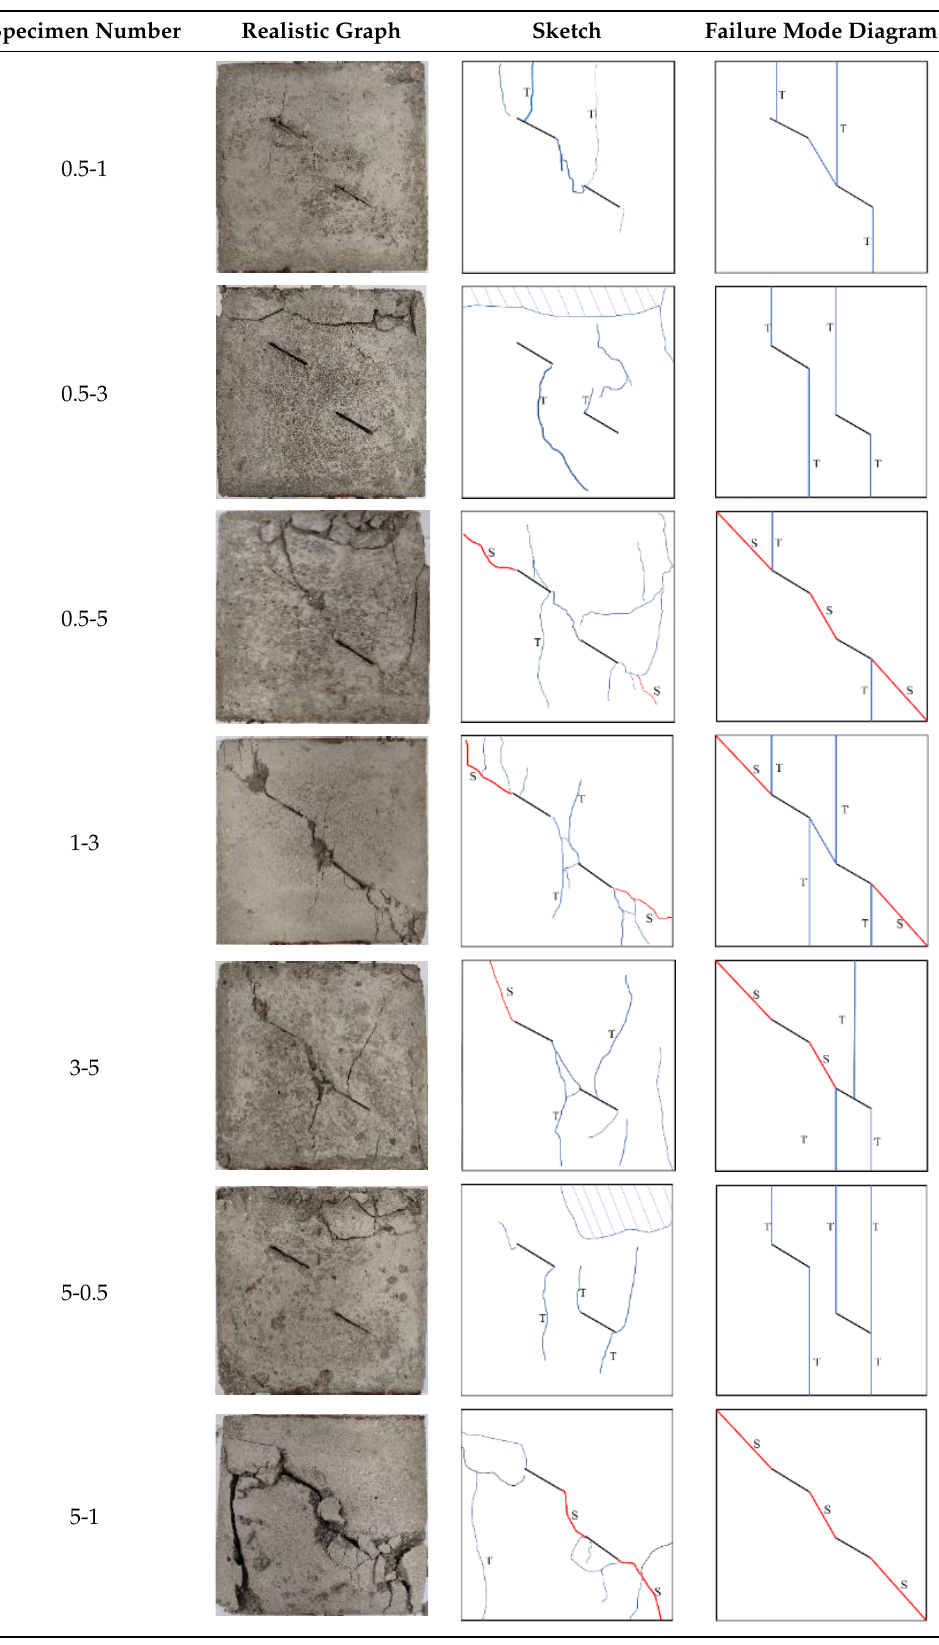
Table 2. Specimens #1 of different sudden change rate crack propagation diagram.